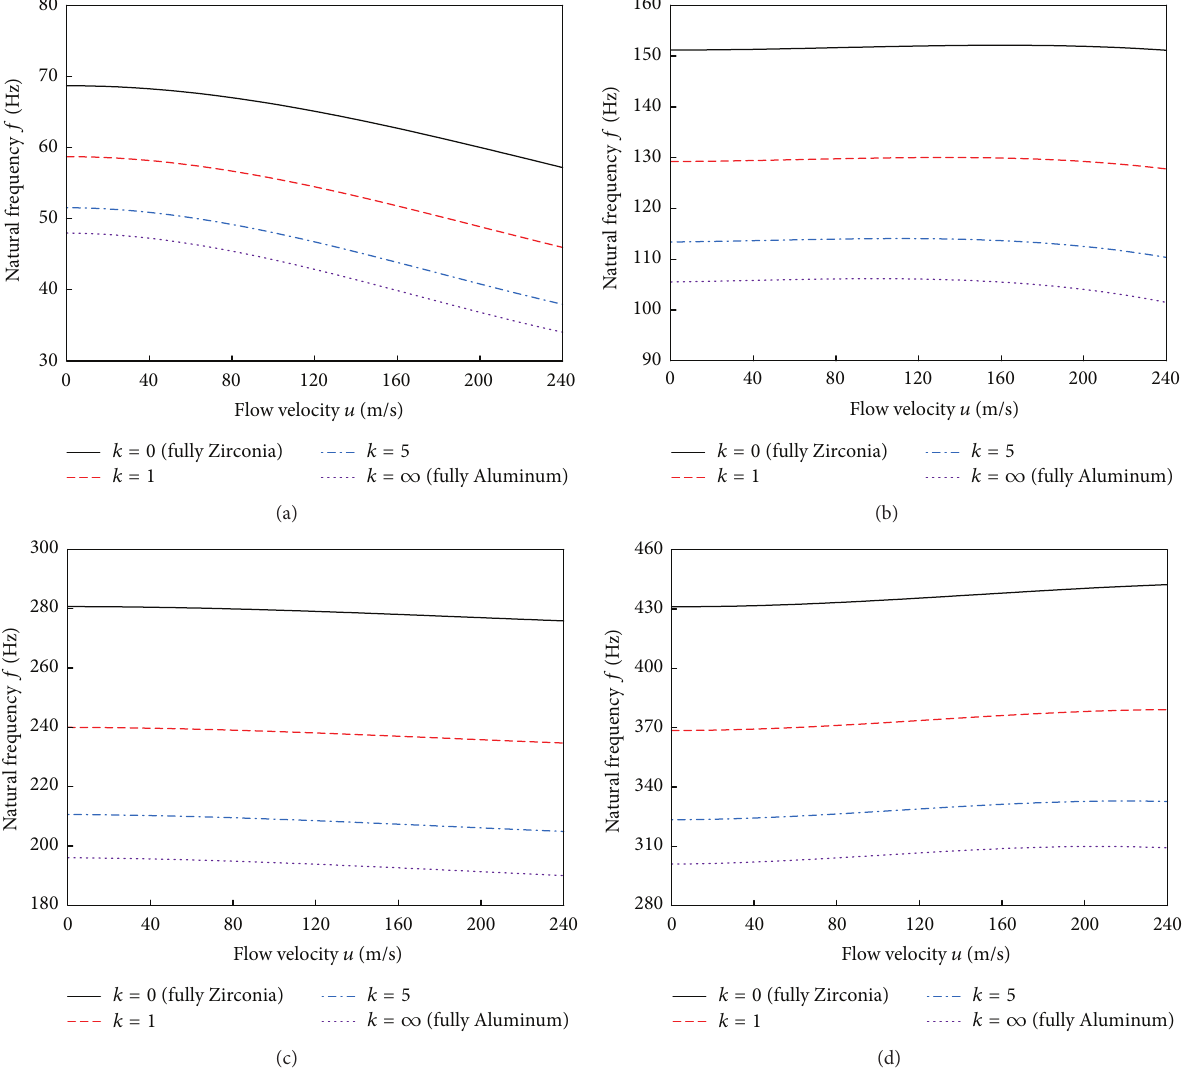
Figure 3: The lowest four natural frequencies of the FGM curved pipes conveying fluid as functions of flow velocity for different values of power gradient index: (a) 1st mode; (b) 2nd mode; (c) 3rd mode; (d) 4th